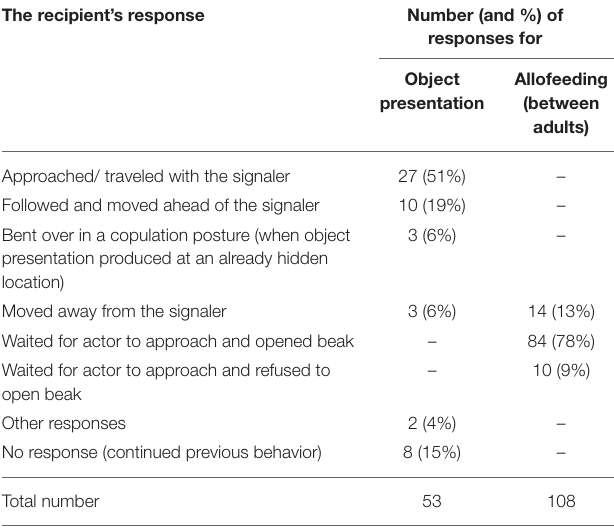
TABLE 4 | Voluntary responses to object presentation and allofeeding